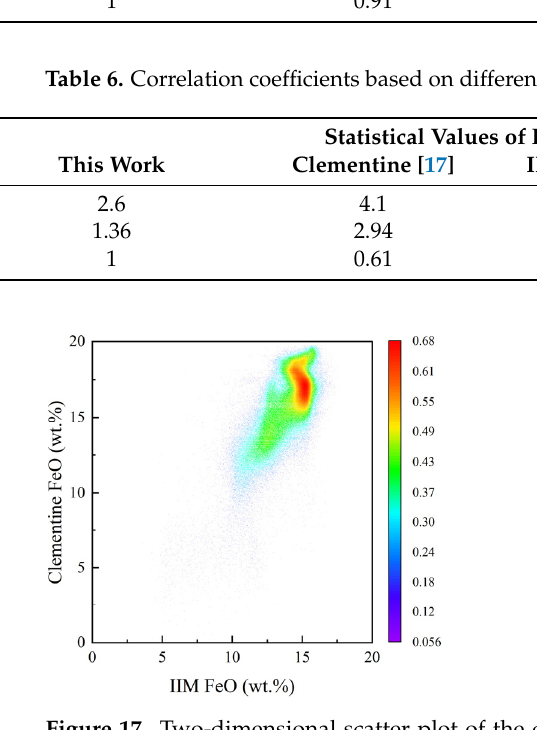
Figure 17. Two-dimensional scatter plot of the difference between the Clementine FeO and IIM FeO abundances. FeO